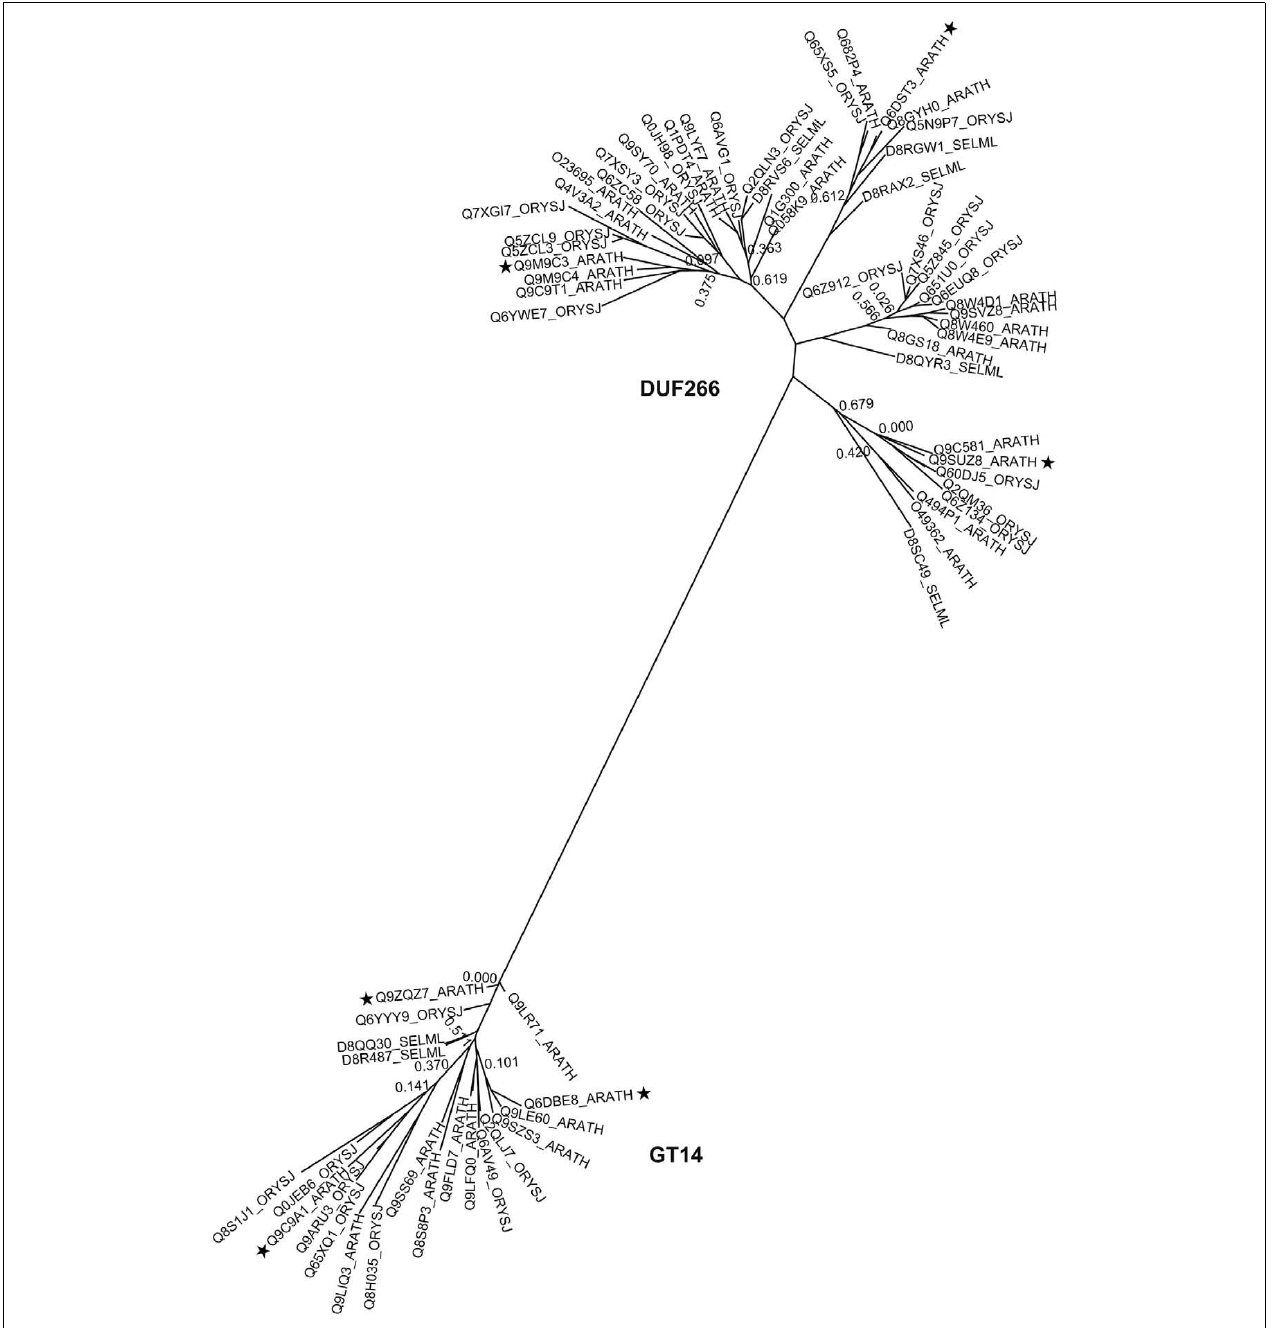
likelihood-ratio test (aLRT).The tree was generated using http://www.phylogeny.fr (Dereeper et al., 2008). Following sequences Q0DT08 and Q0JPU3 were omitted from the tree due to sequence mistakes, mainly intron/exon border malpredictions. Asterisks indicate the selected sequences of the multi alignment displayed in FigureA4